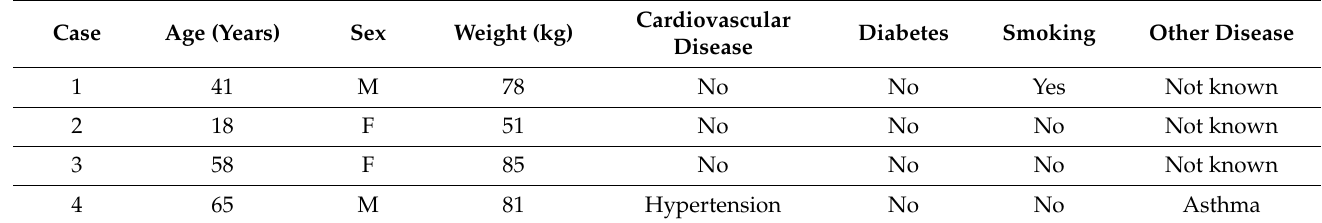
Table 1. Characteristics of the patients included in the study.